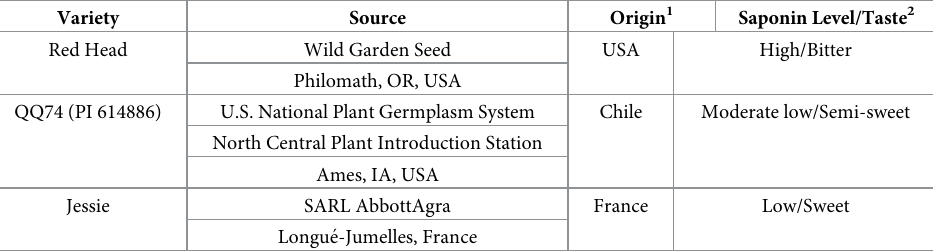
Table 1. Quinoa ( Chenopodium quinoa ) used in the